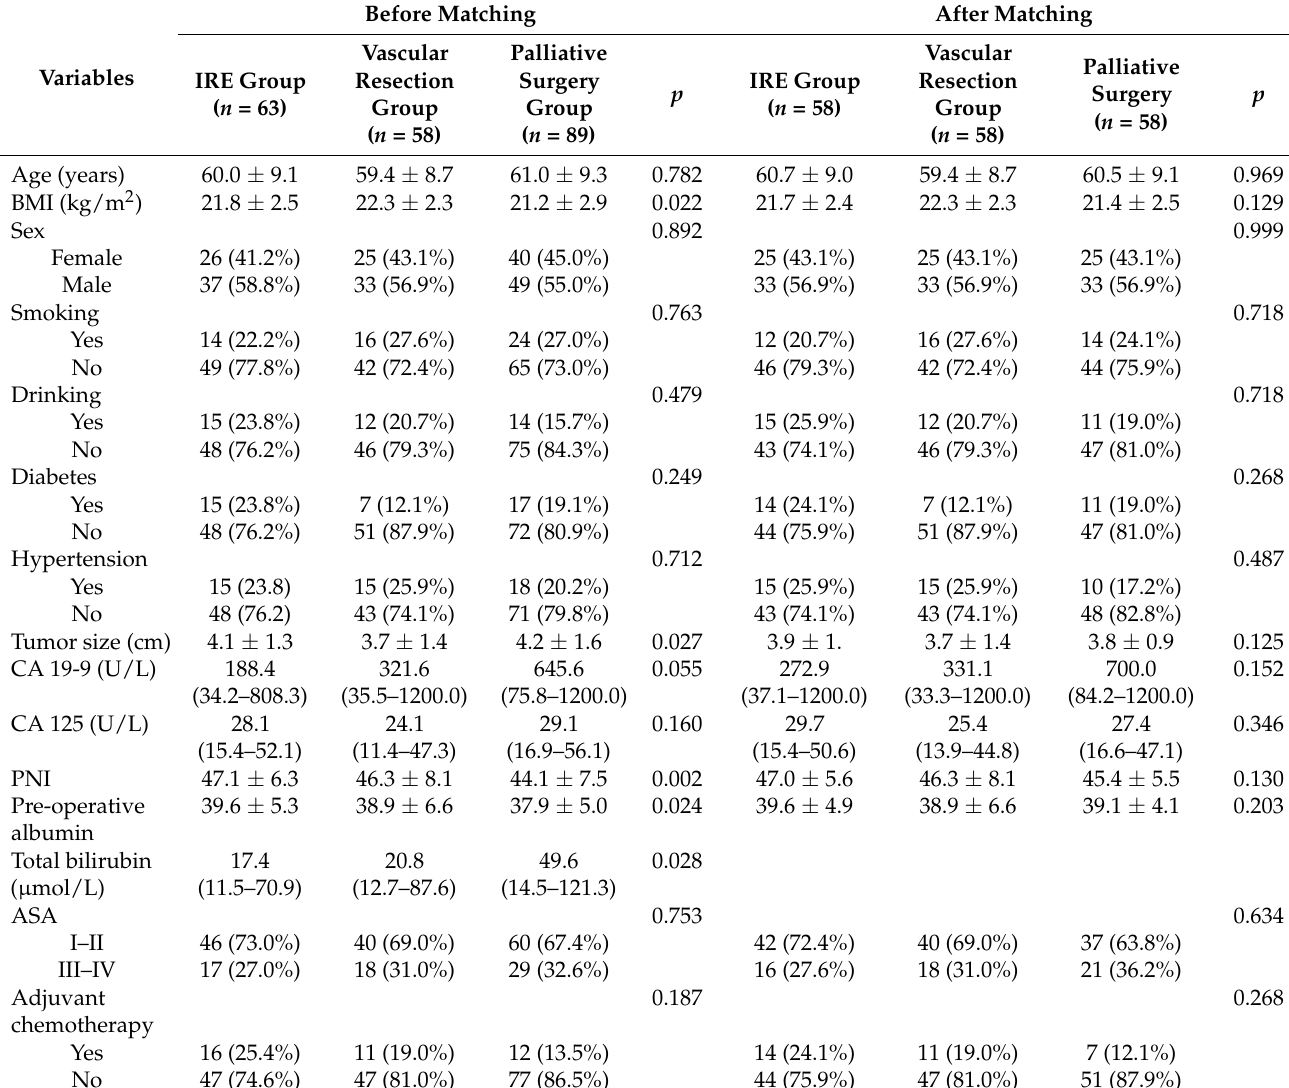
Table 1. Demographics and clinical characteristics of the